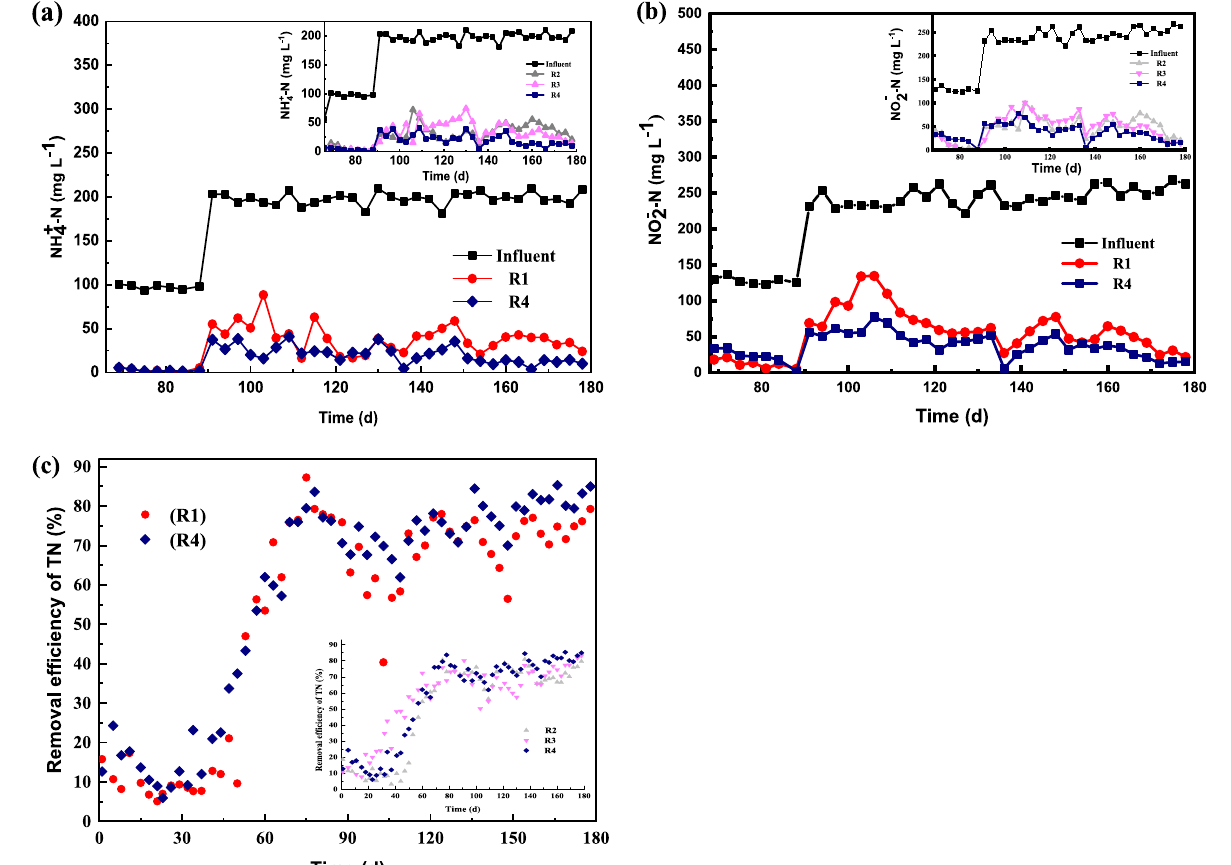
Fig. 2 Nitrogen removal performance of the four reactors in the stabilization period. a NH 4 + – N concentration (mg/L), b NO 2 − – N concentration (mg/L), c removal ef fi ciency (%) of total